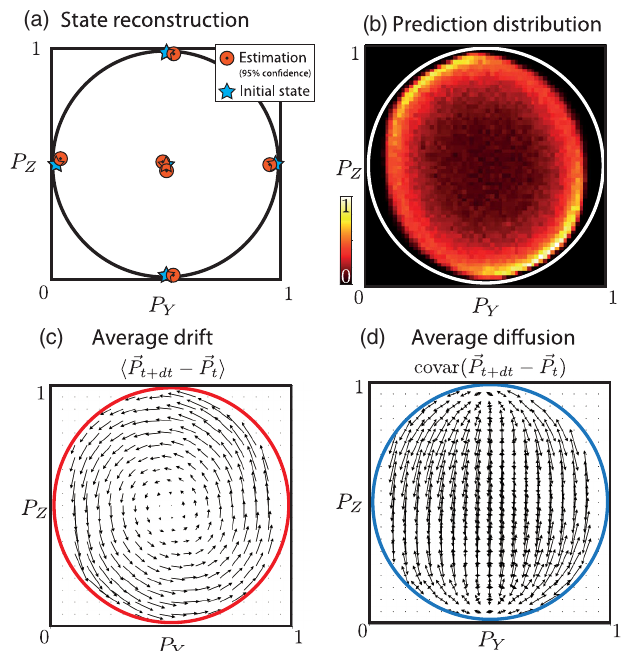
FIG. 4. Parameter estimation of the quantum master equation and initial state tomography. (a) State estimation. Estimation of six initial state preparations (red circles) using maximum-like- lihood estimation on backward RNN predictions (approximately 20 000 trajectories each) initialized from an undetermined projective measurement outcome; the circle radius gives the 95% confidence interval extracted from bootstrapping methods. (b) Distribution of the RNN predictions in the Y and Z measurement basis for all time. (c) Average drift of individual trajectories in the Bloch sphere: the vector map of the averaged evolution of RNN predictions in the Y and Z measurement basis between two consecutive time steps. This map captures the Hamiltonian evolution and the Lindbladian dissipation. (d) Aver- age diffusion of individual trajectories in the Bloch sphere: computed vector map associated with the covariance of the prediction between two consecutive time steps in the Y and Z measurement basis. This map captures the measurement-induced